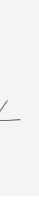
Figure 6. Chemical structure of Oridonin (PubChem